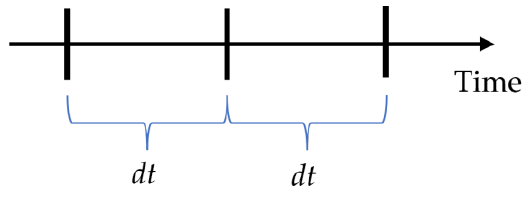
Figure 1. Temporal Figure 1. Temporal segmentation.